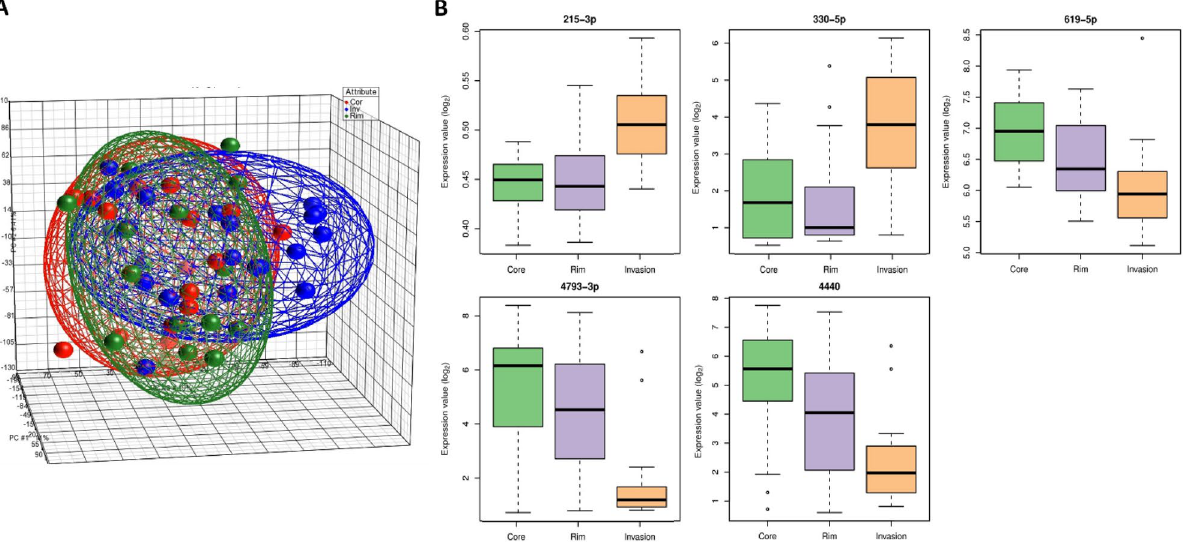
Figure 1. Intratumour heterogeneity in the expression profiles of miRNA in GBM. ( A ) Supervised analysis of miRNA expression profiles based on GBM tumour regions. PCA plot showing that the invasive margin region (blue) forms a cluster that is relatively distinct from the core (red) and the rim (green) regions; although all clusters overlapped due to the similarities between the different regions taken from the same patient tumour. ( B ) Statistically significant differentially expressed miRNAs identified by comparing different GBM tumour regions. miRNA expression values are shown for 15 patient tumours multi-sampled from the core (green), rim (purple), and invasive margin (inv; orange) regions. Statistical analysis was performed using moderated t-tests based on Bioconductor package limma. For the lines in a box and whisker plot: error bars are the 95% confidence interval, the bottom and top of the box are the 25th and 75th percentiles, the line inside the box is the 50th percentile (median), and any outliers are shown as open circles.